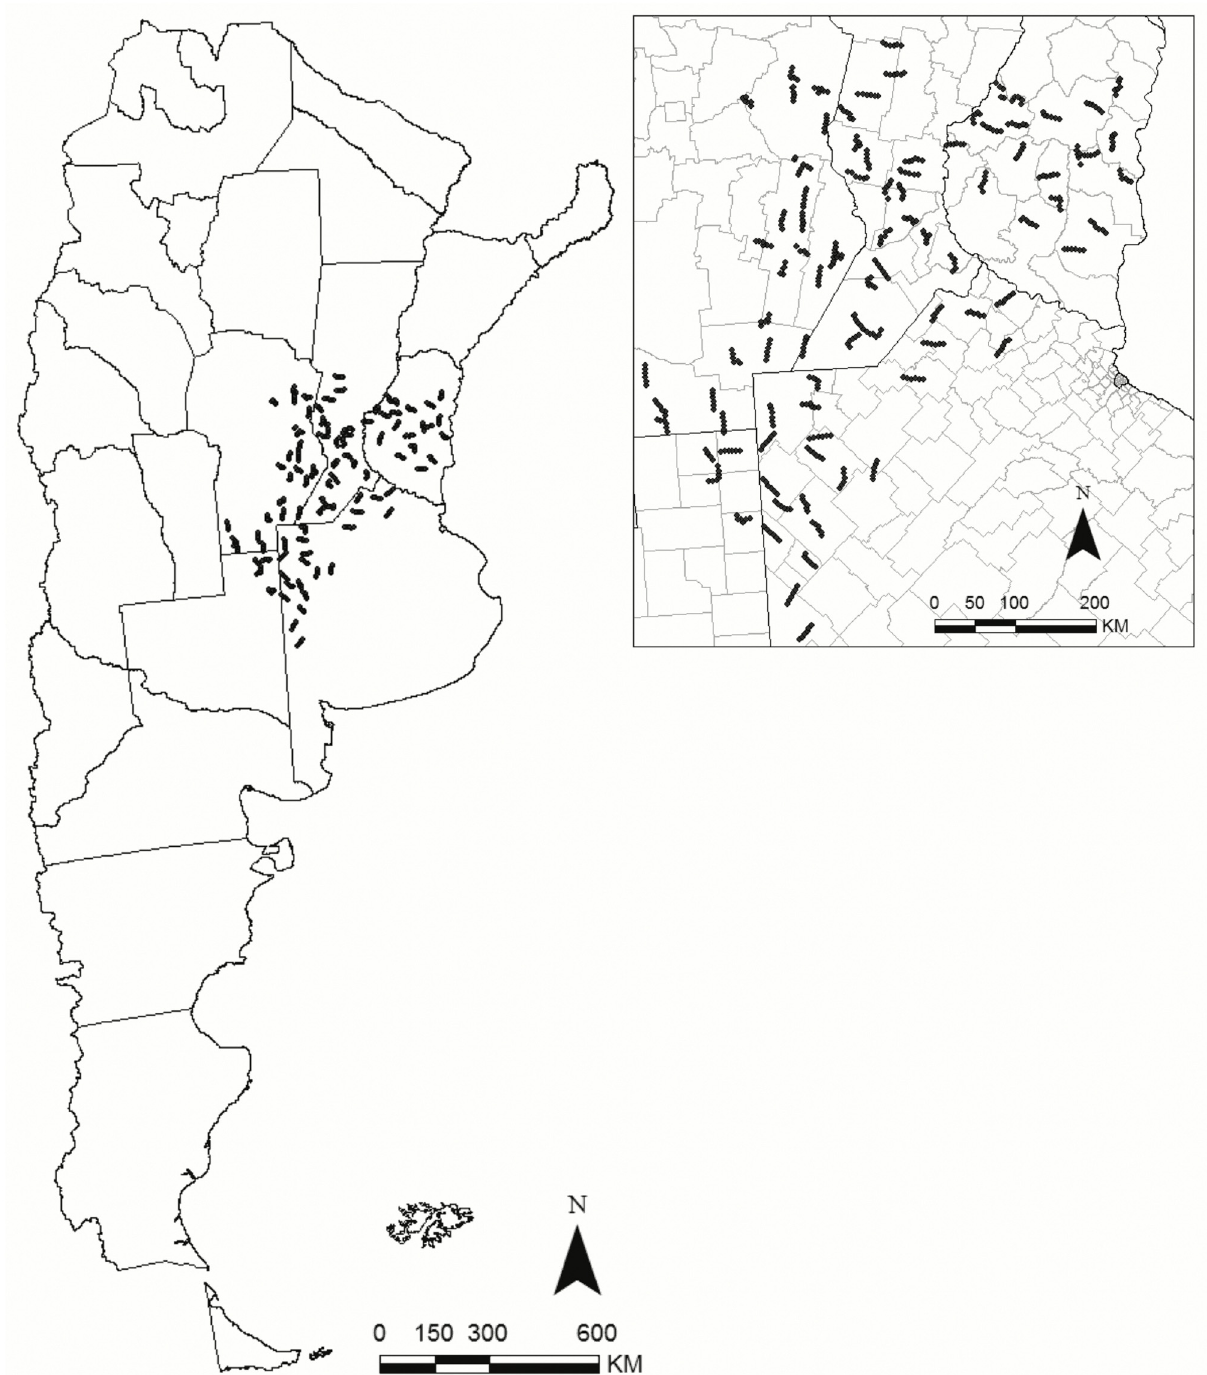
Fig 1. Regional bird monitoring program, indicating monitored routes, as of 2006 – 2012, covering an area 255,000 km 2 , over parts of Entre Ríos, Santa Fe, Córdoba, La Pampa and Buenos Aires provinces, Argentina.